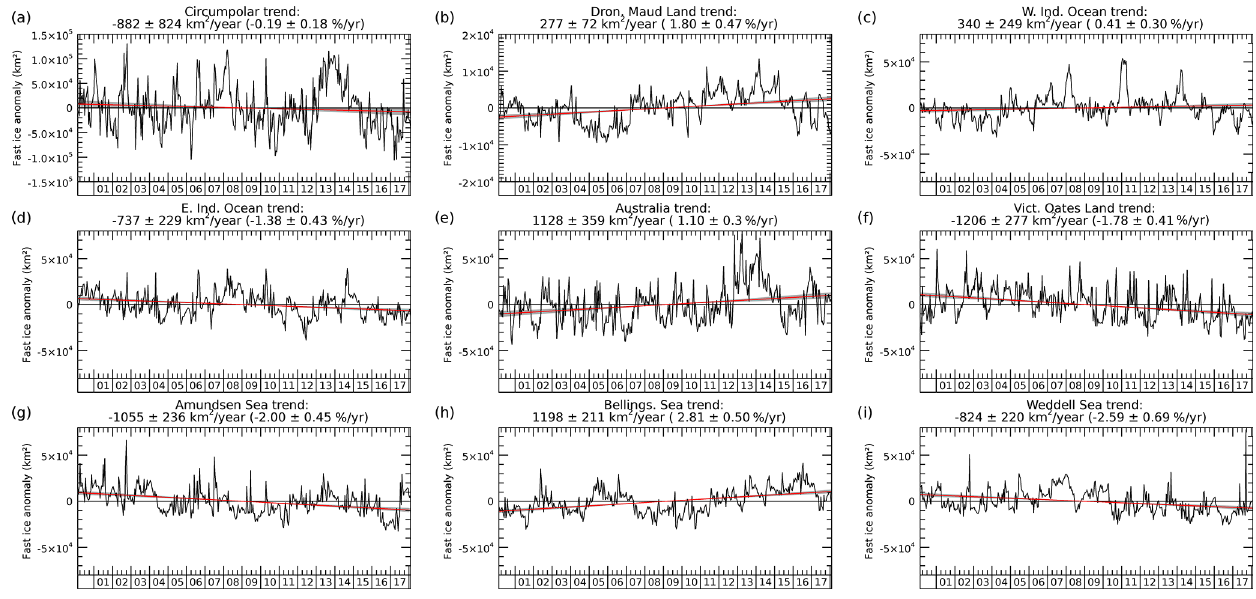
Figure 5. Fast-ice extent anomalies (black line) and linear trends (red line) for the eight fast-ice regions. Trend magnitude and bootstrapped 95% confidence interval are indicated in the title of each subplot. Note the y -axis scale is the same for all plots except panels (a) and (b) . All trends are significant, with a p value of (cid:39) 0 . 00 for all trends except for the circum-Antarctic (panel a ; p (cid:39) 0 . 04) and Western Indian Ocean (panel c ; p (cid:39) 0 . 01)